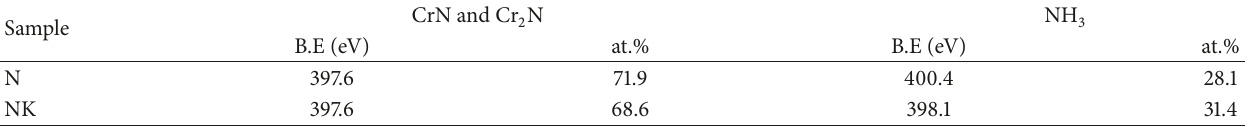
Table 3: XPS fitting results for the N1s core level.